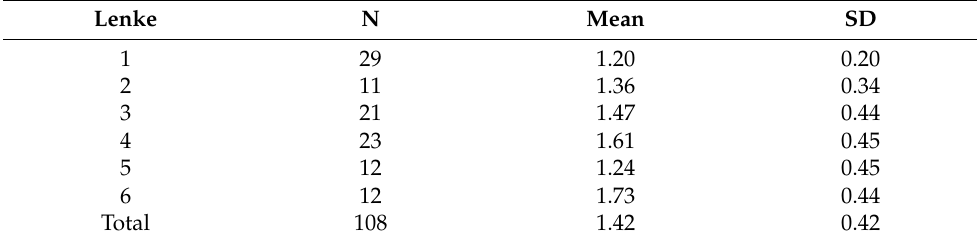
Table 6. Anova, Outcome measures related to the CAVIDRA score (QLPSD) according to the type of curve in the Lenke classification.